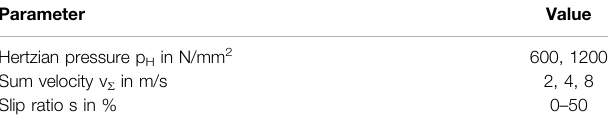
TABLE 1 | Operating conditions at the twin-disk tribometer.